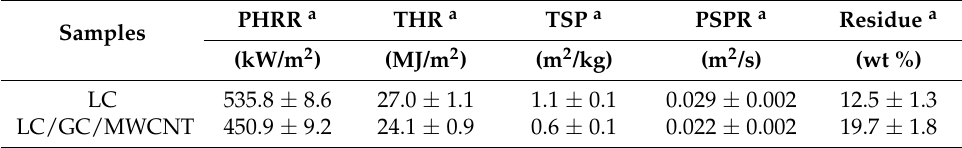
Table 1. Cone calorimeter data of LC composite and LC/GC/MWCNT